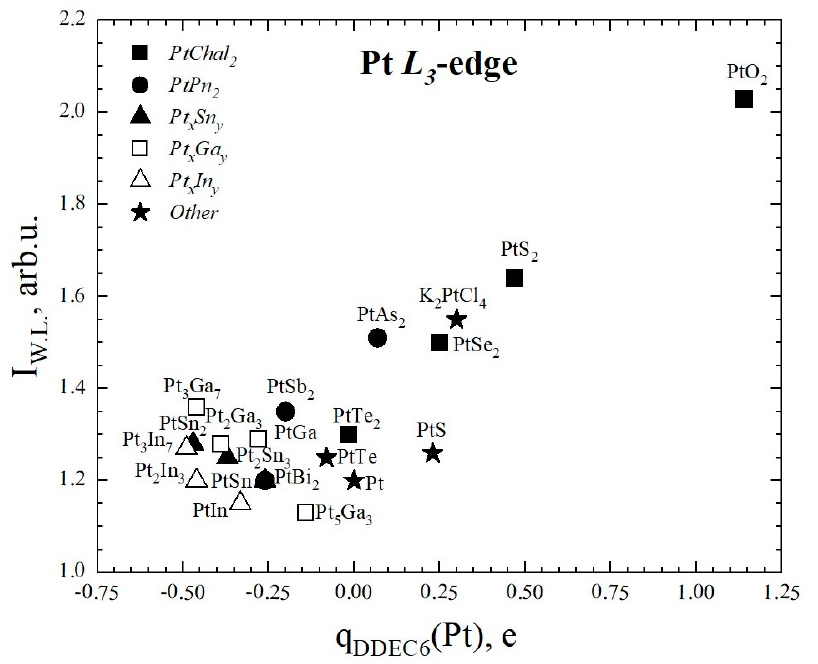
Figure 3. The white line intensity (I W.L. ) of Pt L 3 -edge spectra vs. DDEC6 Pt partial atomic charge.